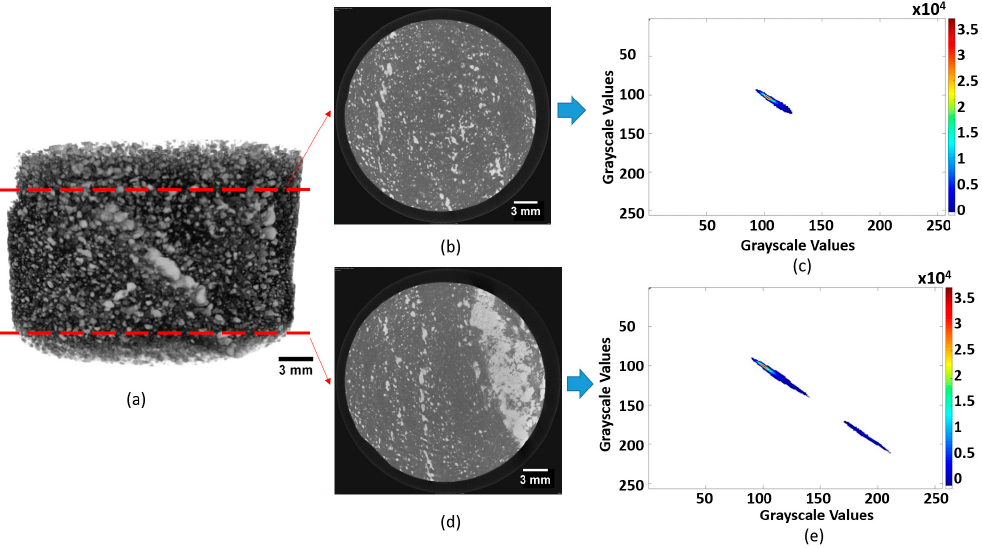
Figure 14. Relation of GLCM matrix on direction 1 (0,1,0) to the texture of a drill core. ( a ) Drill core volume showing horizontal slices, ( b ) and ( d ). Horizontal slices of the drill core, ( c ) and ( e ), are the GLCM matrices as a heat map, alongside its legend showing red for high frequency and blue for low. The results clearly show difference in the GLCM as slice ( d ) has more sulphide mineralization as compared to slice ( b ). This can be seen as the higher correlation frequency between the brighter phases, which usually indicates the sulphide minerals.